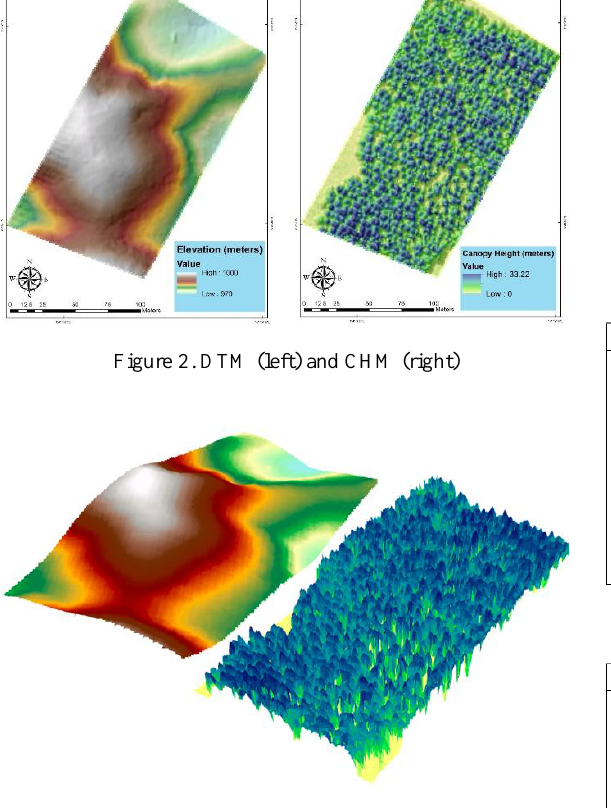
Figure 3. 3D Model of DTM (left) and CHM (right) 2.1.2.